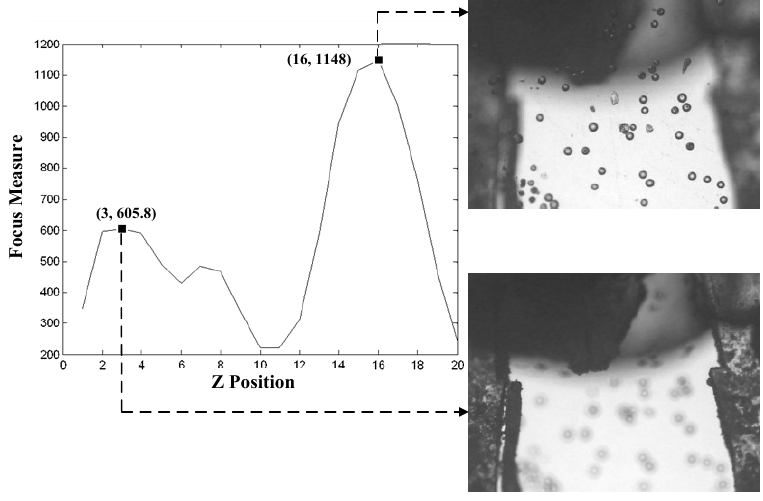
Figure 7. Focus measure of E PHF 2 in focusing gripper tips and particles.